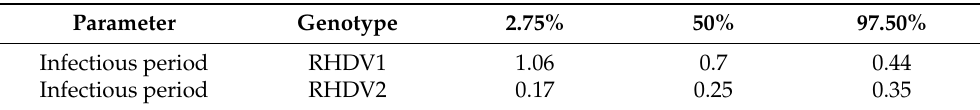
Table 2. Posterior median and 95% CrI for the estimated infectious period (estimated as 1/delta and expressed as fractional years) from BDMM-prime